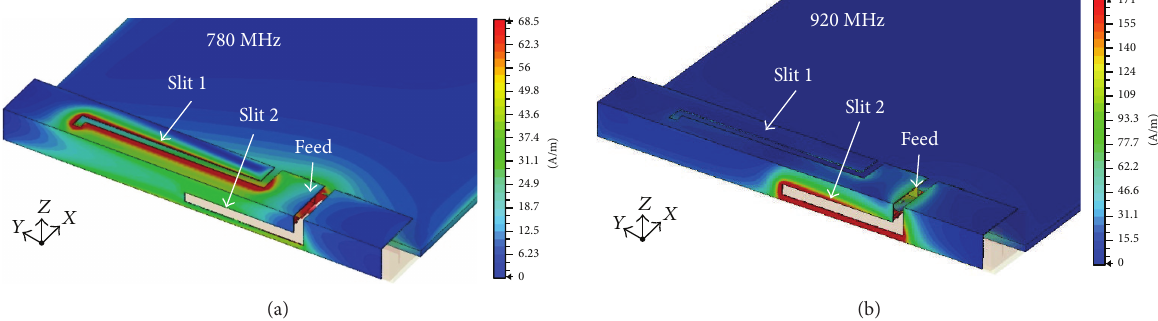
Figure 11: Simulated surface current distribution of the proposed antenna including the ground plane: (a) at 780 MHz (State 1) and (b) at 920 MHz (State